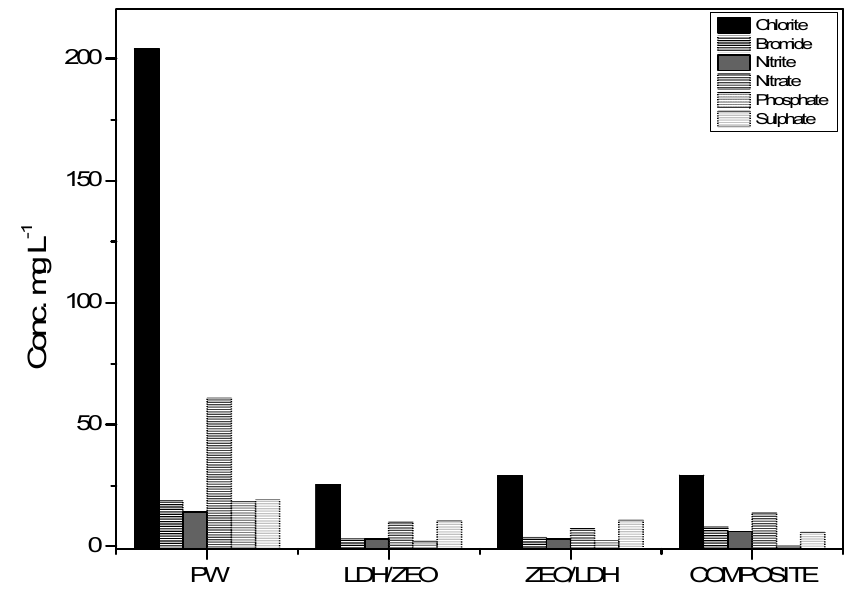
Figure 6. Chloride, bromide, nitrite, nitrate, phosphate and sulphate ion concentrations present in